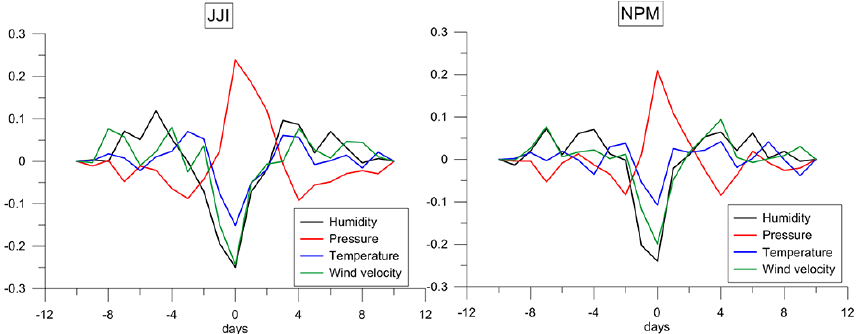
Figure 2. Cross-covariance functions for the average residual amplitude at nighttime of the JJI signal (left) and NPM signal (right) received in Yuzhno-Kurilsk, and meteorological parameters from the local weather station during 2012. The ordinate ( y axis) is the correlation coefficient.